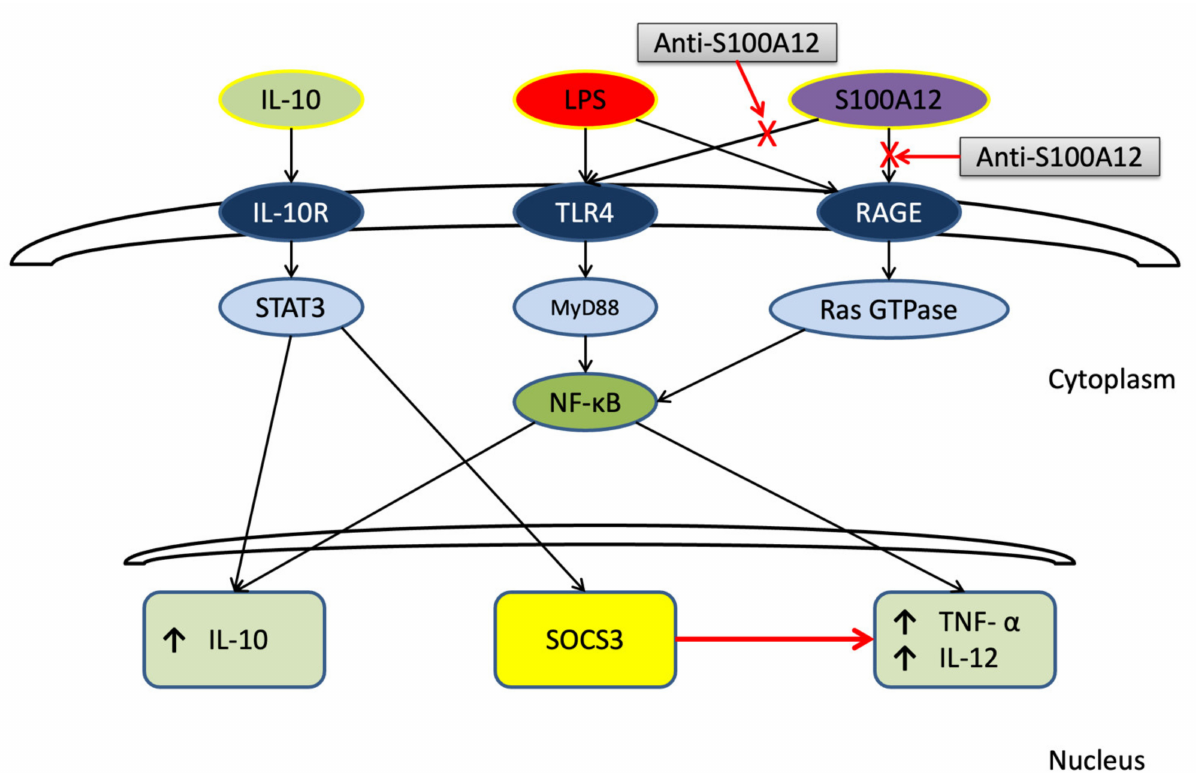
Figure 3. A proposed schematic mechanism that shows S100A12 may modulate tumor necrosis factor (TNF)- α and interleukin (IL)-10 production through lipopolysaccharide (LPS). LPS links Toll- like receptor (TLR) 4 to activate nuclear factor-kappa B (NF- κ B) through myeloid differentiation primary response 88 (MYD88). The activated NF- κ B in the cytoplasm is then translocated into the nucleus where it binds to specific sequences of DNA and increases IL-10, IL-12, and TNF- α gene expressions. Extracellular IL-10 binds to IL-10 receptors and activates signal transducer and activator of transcription (STAT)3. Then, STAT3 is translocated to the cell nucleus and induces IL-10 gene expression. Activating STAT3 signaling also induces suppressor of cytokine signaling (SOCS)3 to suppress IL-12 and TNF- α gene expression. Once RAGE is bound to LPS or S100A12, NF- κ B is activated by the active form of rat sarcoma (Ras), Ras nucleotide guanosine triphosphate (GTP) hydrolases (GTPase). S100A12 may competitively bind to TLR4/RAGE and the affinity between S100A12 and TLR4/RAGE may be lower than that between LPS and TLR/4RAGE. This results in increased IL-10 and TNF- α production with S100A12 being